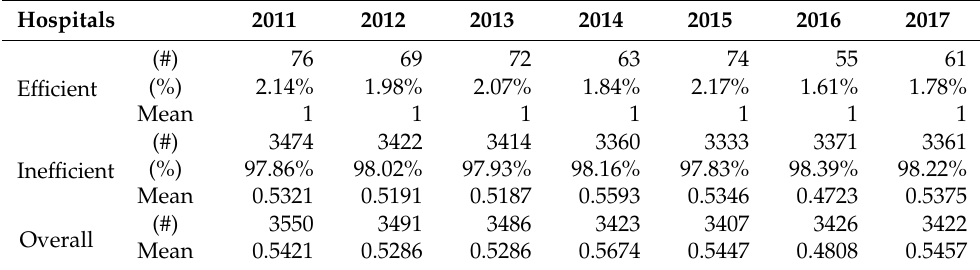
Table 2. Summary of Efficiency Measurements.